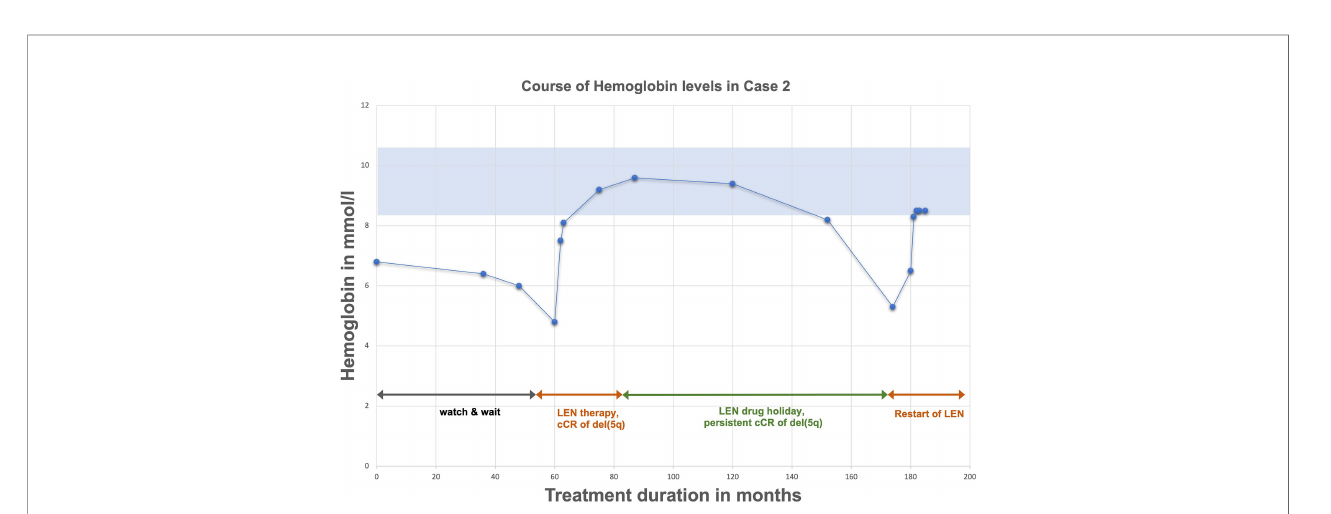
FIGURE 2 | Exemplary course of Hemoglobin (case 2) upon treatment and drug holiday with lenalidomide.